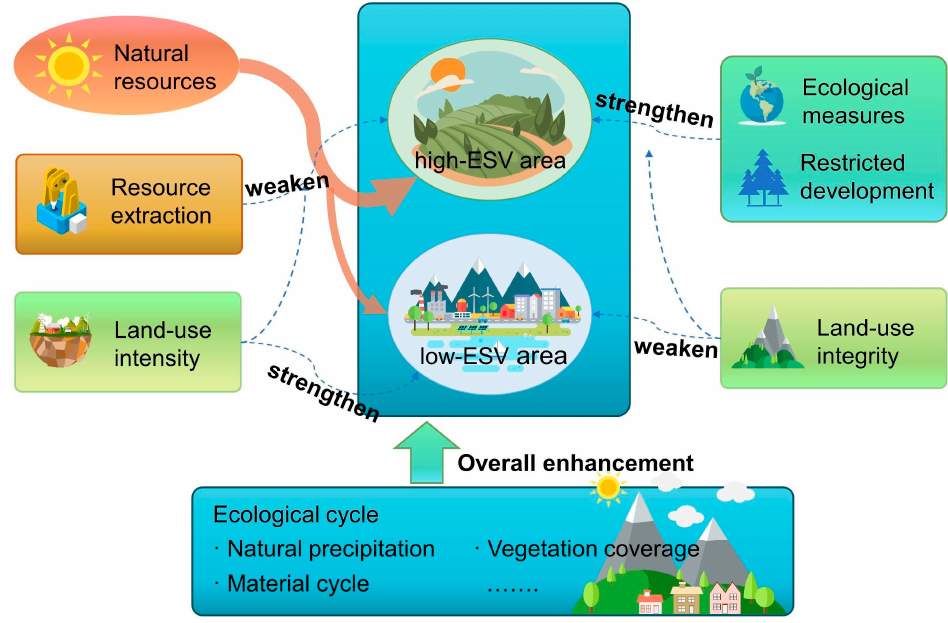
Figure 10. The influencing mechanism of ecosystem service value evolution.